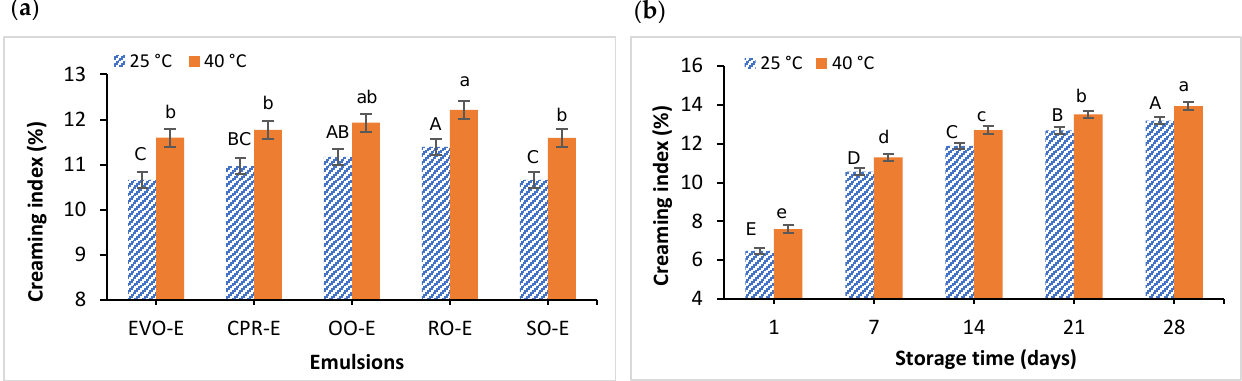
Figure 2. Creaming index (%) means values and 95% confidence intervals of the conventional emulsions stored at 25 °C and 40 °C. ( a ) Effect of oil type; ( b ) effect of storage time. Different capital letters indicate significant differences between mean at 25 °C, and different lower-case letters indicate significant differences between means at 40 °C. Conventional emulsions (-E) prepared with the different oils: extra virgin olive oil (EVO-E), cold-pressed rapeseed oil (CPR-E), olive oil (OO-E), rapeseed oil (RO-E), sunflower oil (SO-E).